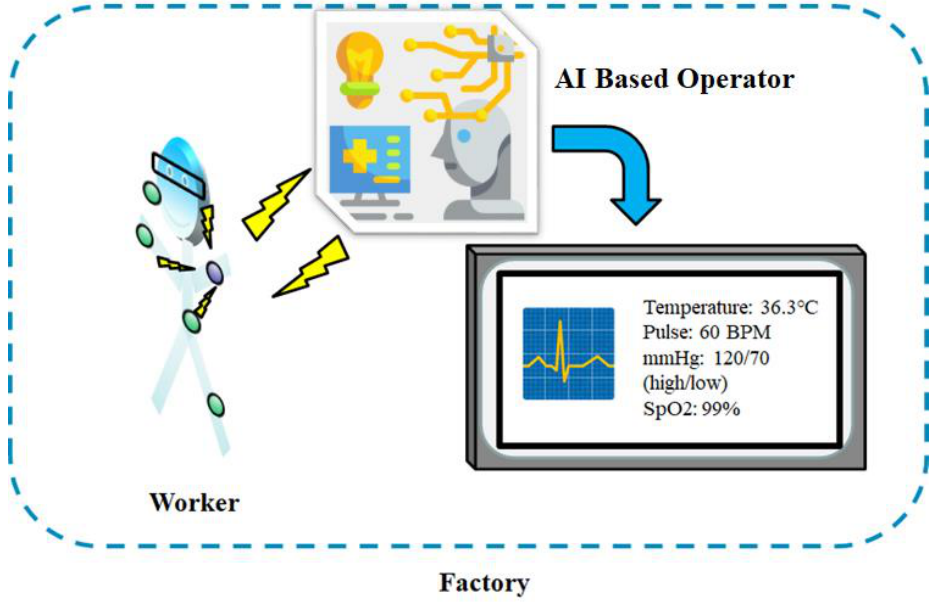
Figure 3. Supposed use case. The artificial intelligence (AI)-based operator monitors the vital data of the worker in the factory wearing the smart body area network (SmartBAN). Table 4. List of sensors and target data rates.